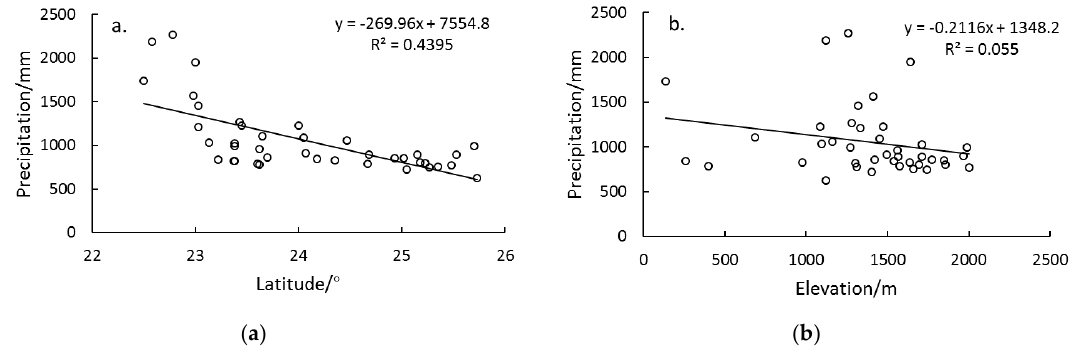
Figure 2. Scatterplots between annual average precipitation and ( a ) latitude; ( b ) elevation for 40 RGS from 2001 to 2015.